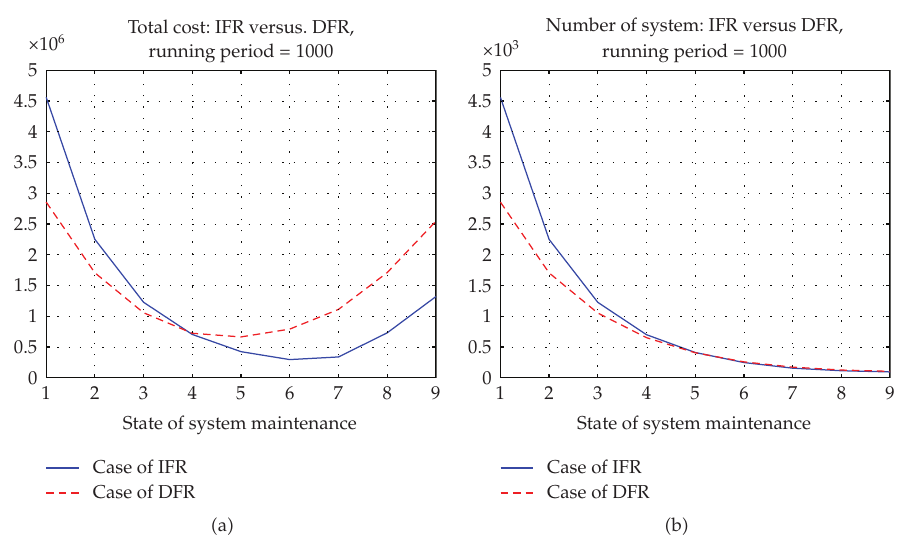
Figure 5: Optimal maintenance policy: IFR versus DFR with T (cid:5) 1000.